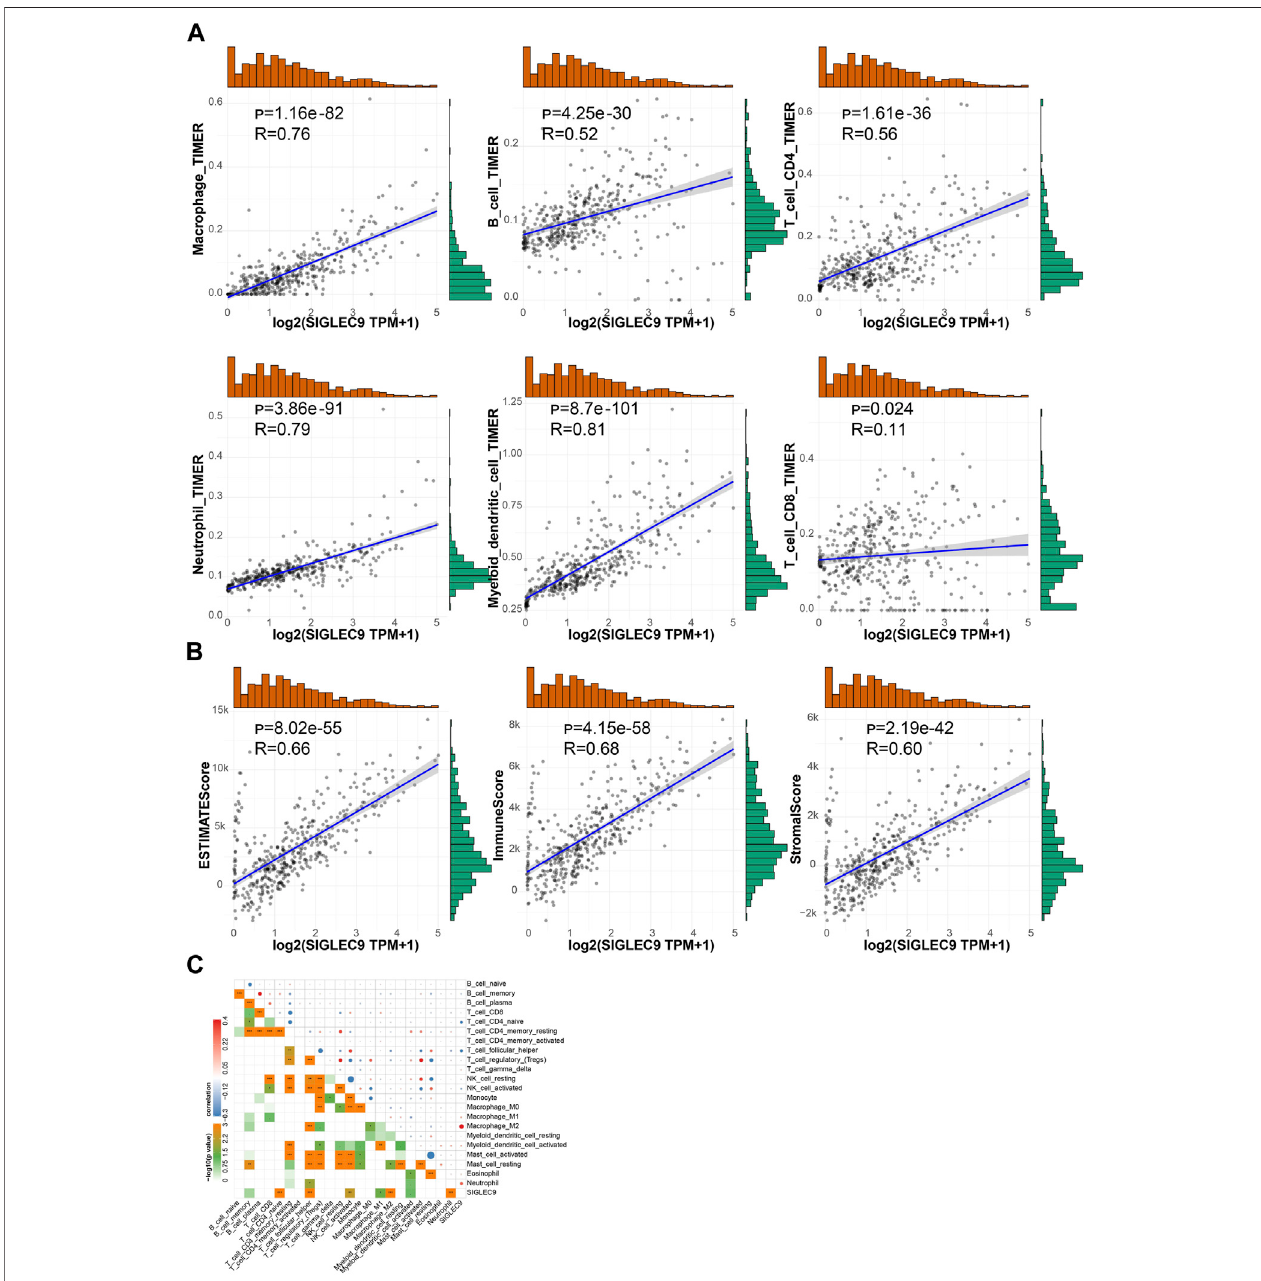
FIGURE 9 | Correlation between Siglc-9 expression and immune cell in fi ltration and immune score, stromal score, and ESTIMATE score in brain lower-grade glioma (LGG). (A) Relationship between Siglec-9 expression and immune cell in fi ltration (macrophage, B cell, CD4 + T cell, neutrophil, dendritic cell, and CD8 + T cell). (B) Correlation between Siglec-9 mRNA expression and ESTIMATE score, immune score, and stromal score. (C) Correlation between Siglec-9 expression and speci fi c immune cell in fi ltration. (Spearman correlation, p < 0.05 was considered signi fi cant, * p < 0.05, ** p < 0.01, *** p < 0.001. The larger the R -value, the greater the